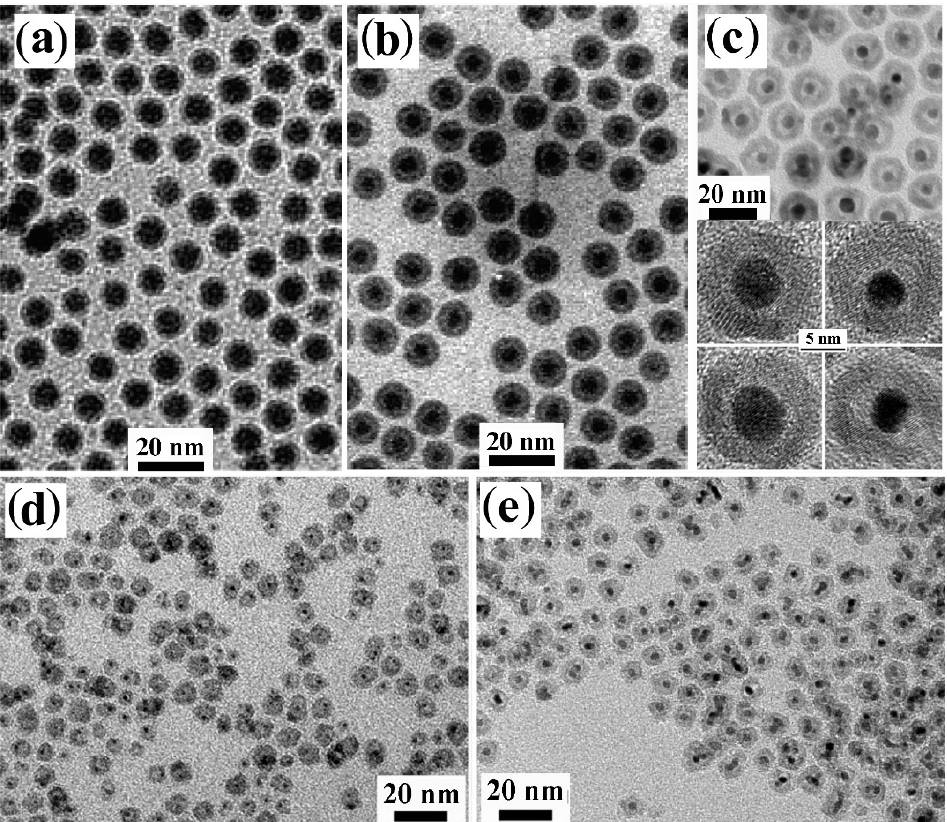
Figure 4. Gallery of representative core@shell and yolk@shell CNHSs prepared by red-ox replace- ment over on metal seeds, followed by hollowing (cf. Scheme 2d,e). The panels display low- magnification TEM and HRTEM images of: ( a , b ) Fe@Fe 3 O 4 core@shell CNHSs and corresponding yolk@shell Fe@Fe 3 O 4 CNHSs thereof, respectively (adapted with permission from Ref. [174], Copy- right 2007, American Chemical Society); ( c ) Au@Fe 3 O 4 yolk@shell CNHSs (adapted with permission from Ref. [191], Copyright 2008, Wiley-VCH Verlag GmbH & Co. KGaA); ( d , e ) FePt@Fe 3 O 4 and Pt@Fe 3 O 4 yolk@shell CNHSs (adapted with permission from Ref. [188], Copyright 2008, American Chemical